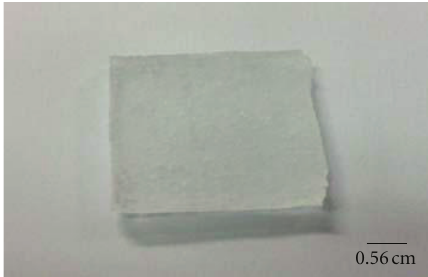
Figure 16: Embedded microvoids film with microlens array struc- ture.